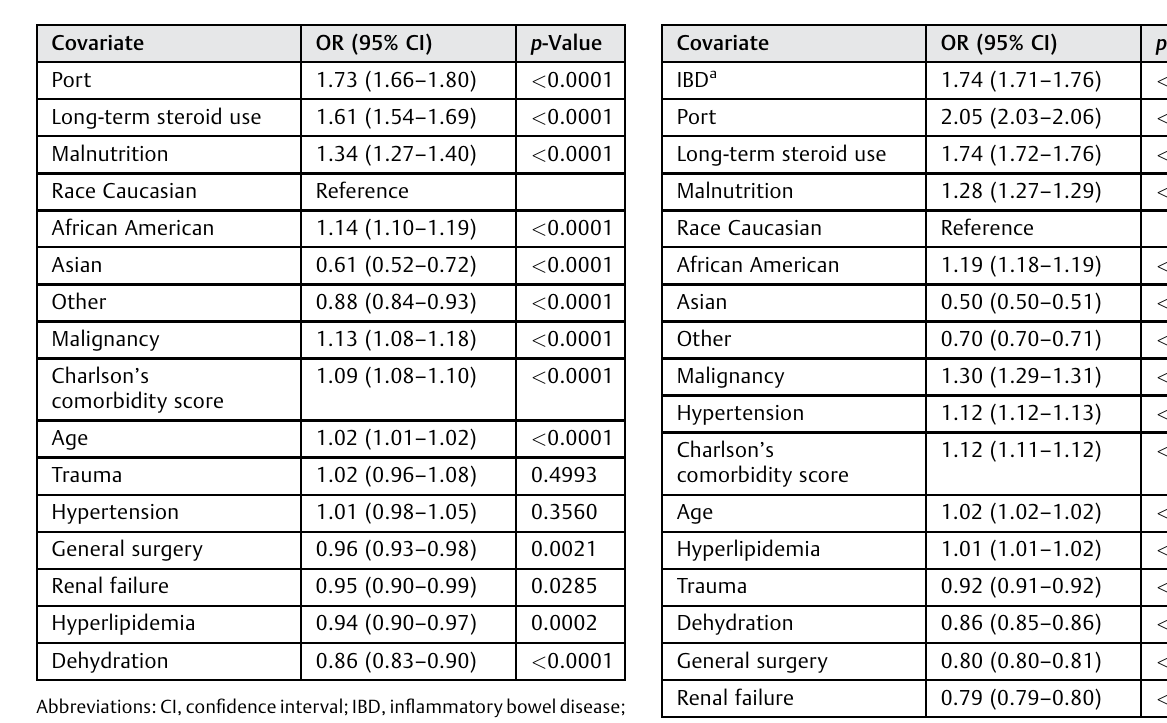
Table 3 Multivariable logistic regression odds ratios for thrombosis in IBD